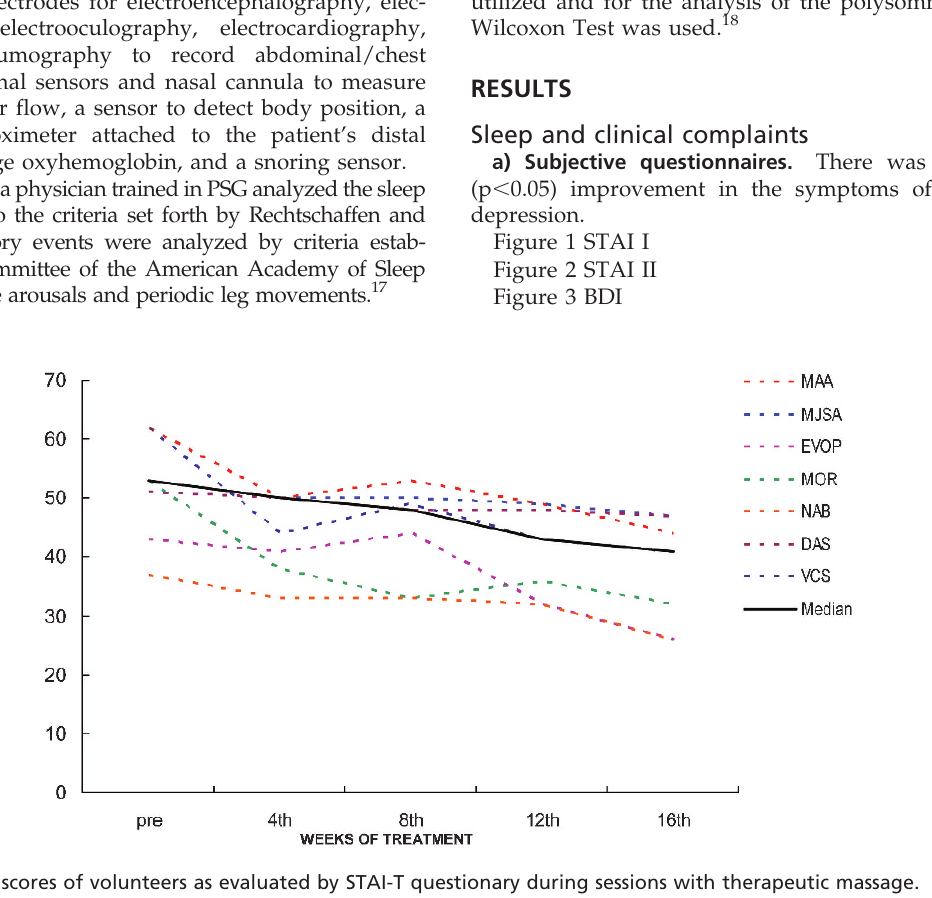
Figure 2 - Anxiety scores of volunteers as evaluated by STAI-T questionary during sessions with therapeutic